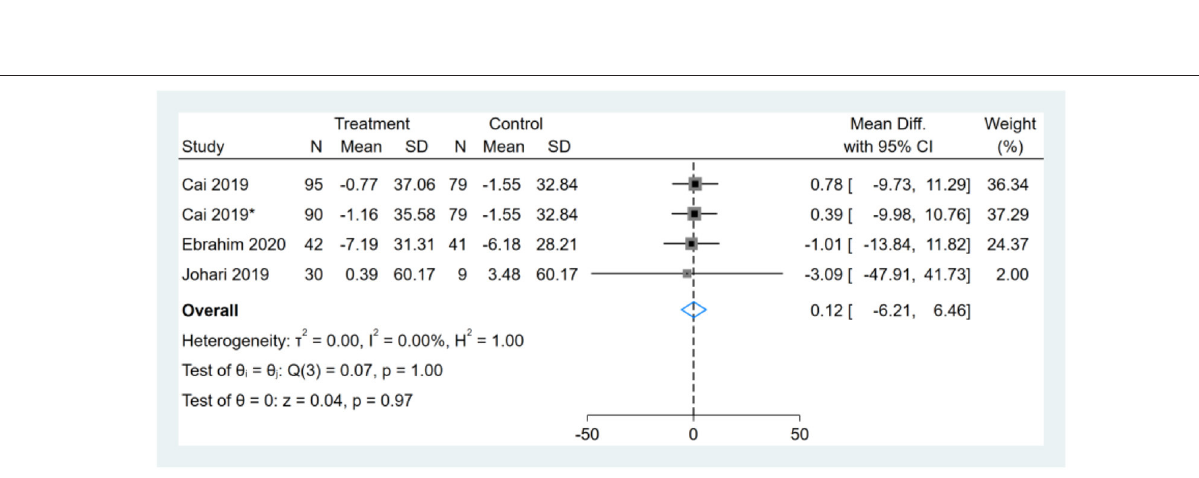
FIGURE 12 | Forest plot analysis showing changes in total cholesterol (TC). *This study has two fasting intervention groups.